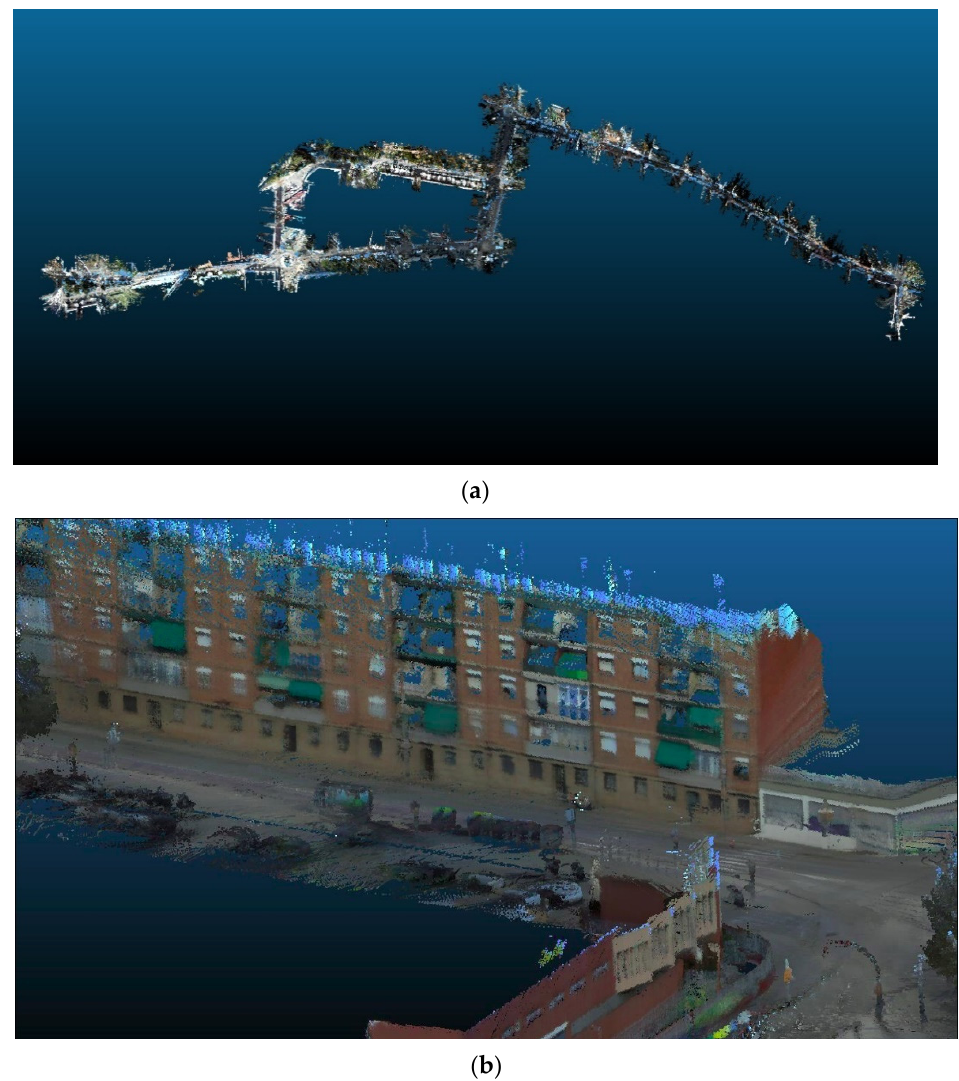
Figure 10. The point cloud generated with the mobile mapping system after texture-mapping with our custom algorithm, exploiting the estimated calibration parameters. ( a ) Top overall view. ( b ) A detailed view.